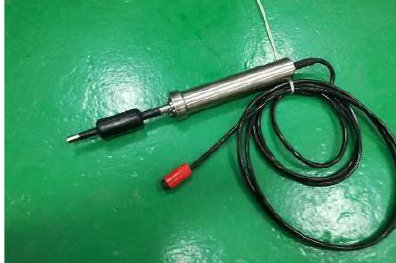
Figure 10. Electromagnetic current meter picture.